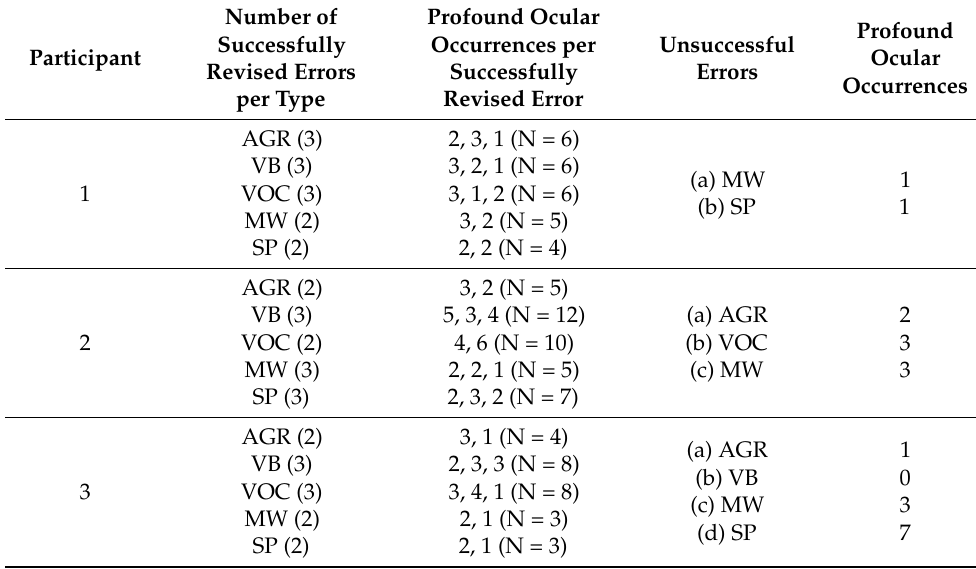
Table 11. Five types of errors per participant and a comparison with profound ocular